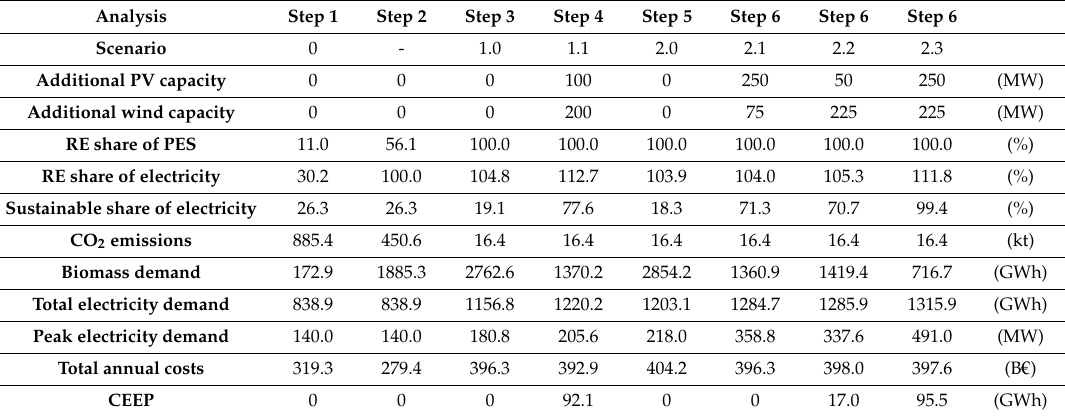
Table 1. Overview data of the main scenarios.